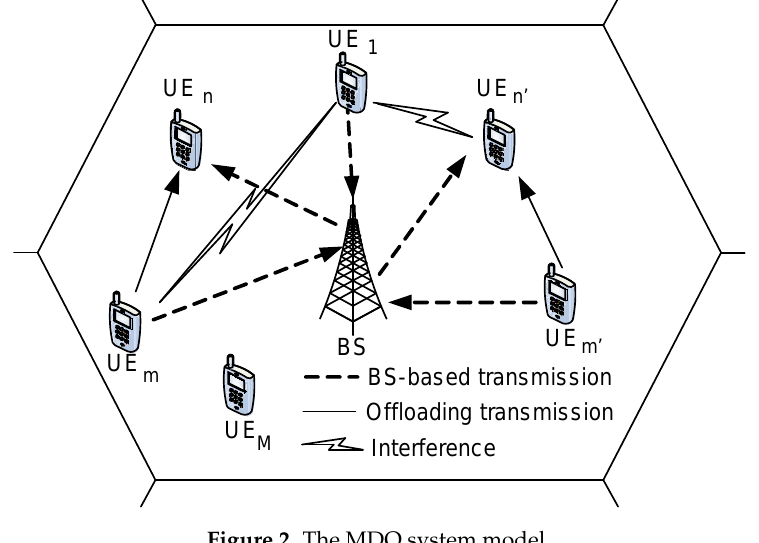
Figure 2. The MDO system